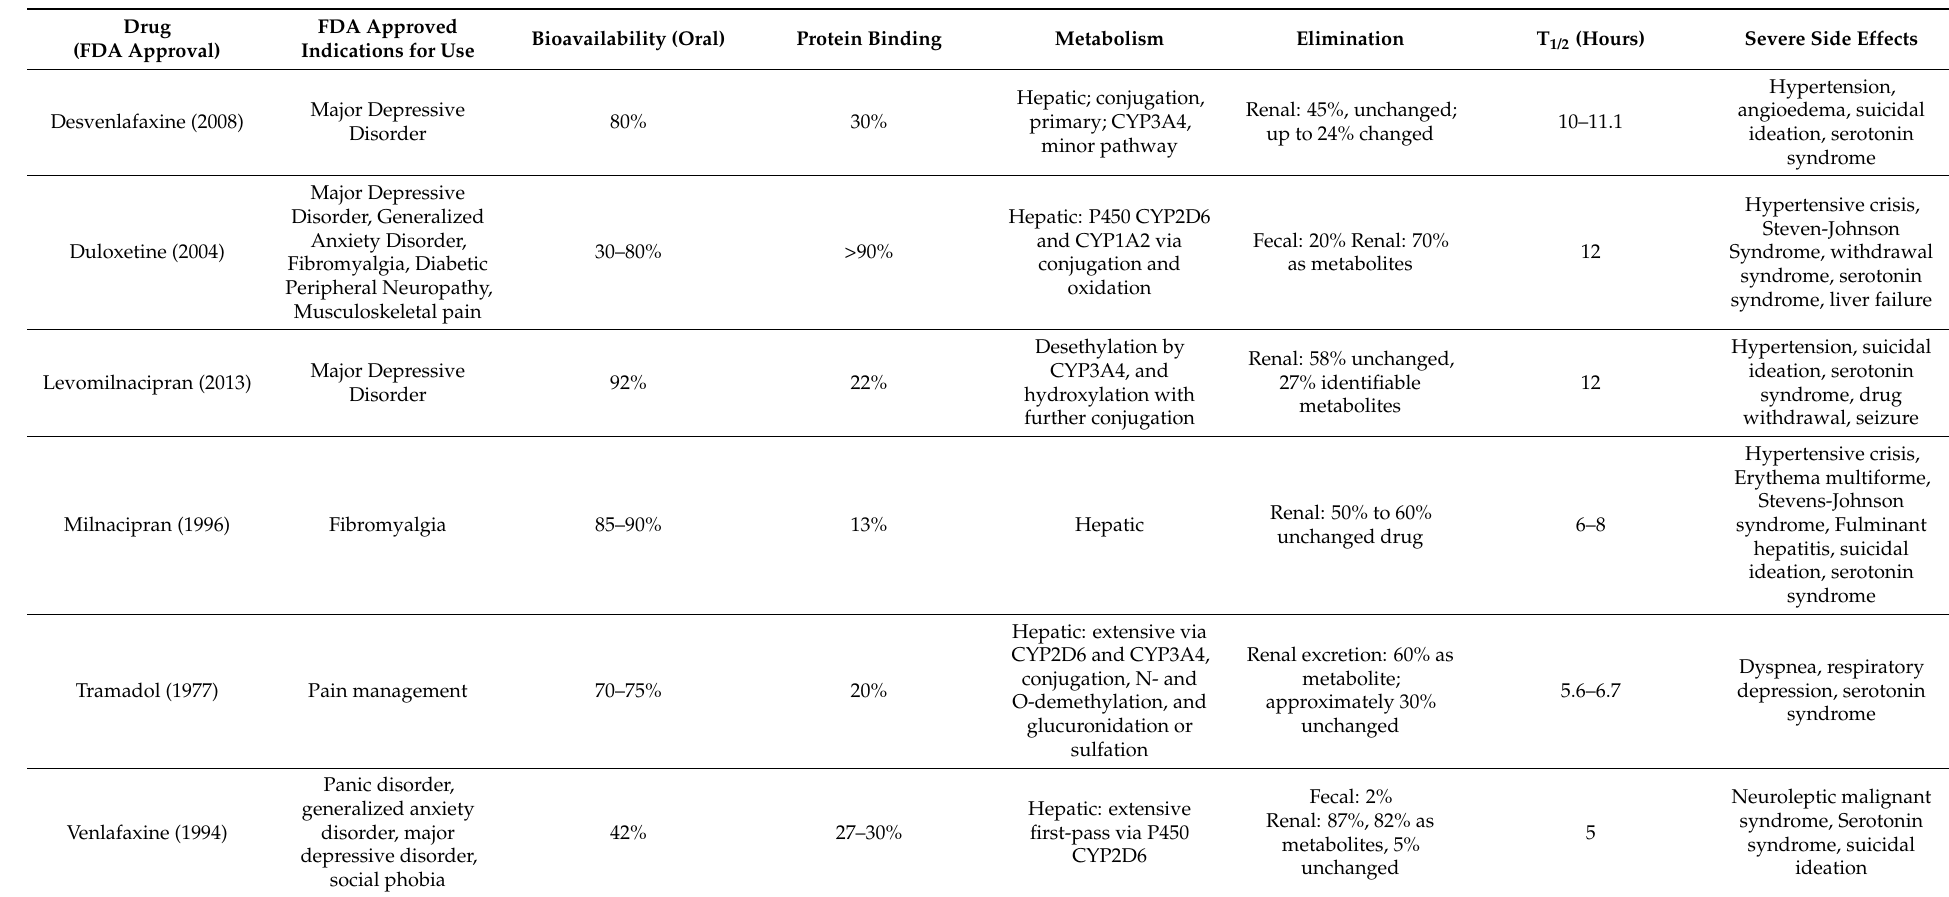
Table 1. Commonly-prescribed serotonin-norepinephrine reuptake